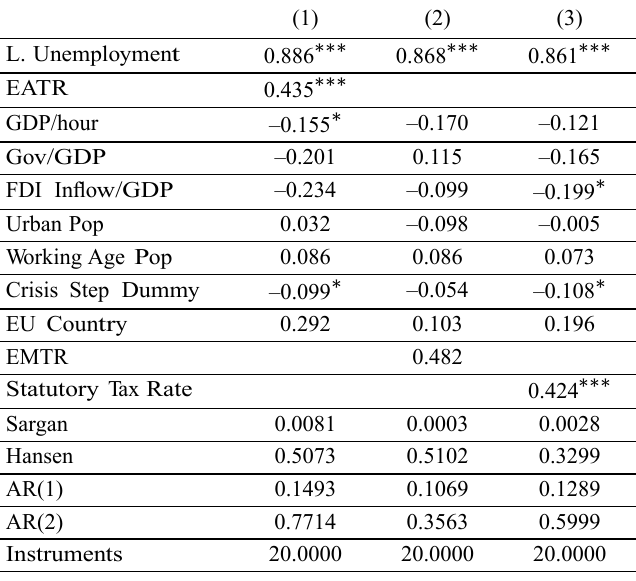
Table 3. Estimation results with differing tax measures